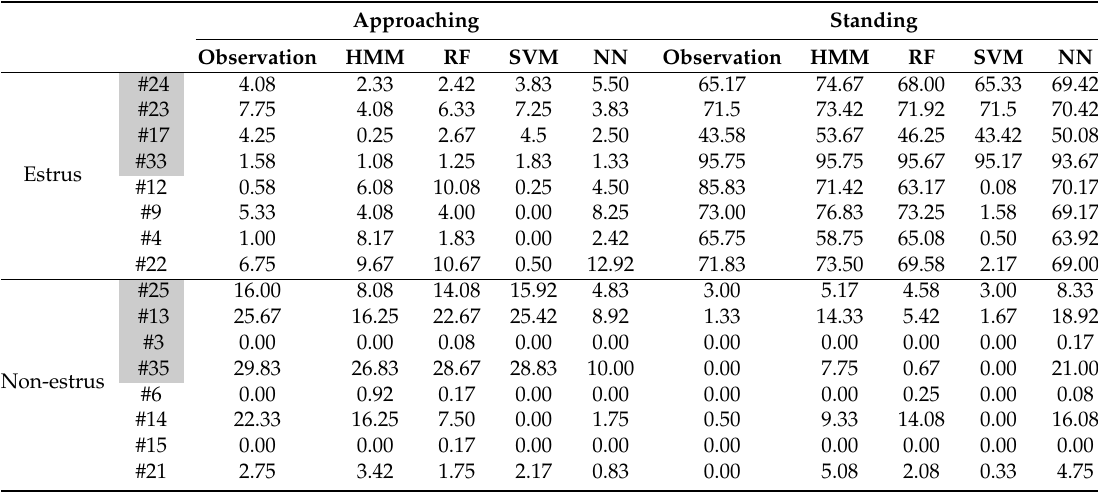
Table 5. Percentage of time spent in estrus and non-estrus behavior from observation and HMM. Gray-colored cells represent goats used for training data (unit: